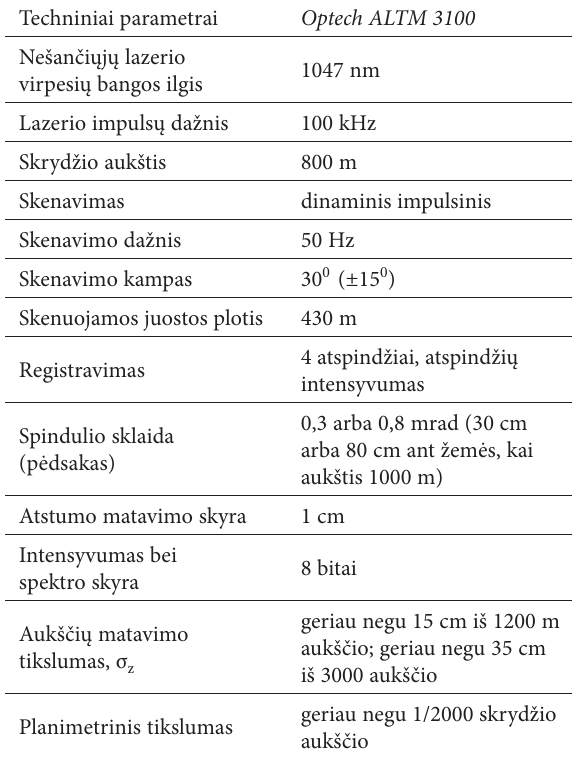
Table 4. Technical specifications of data acquisition by scanner